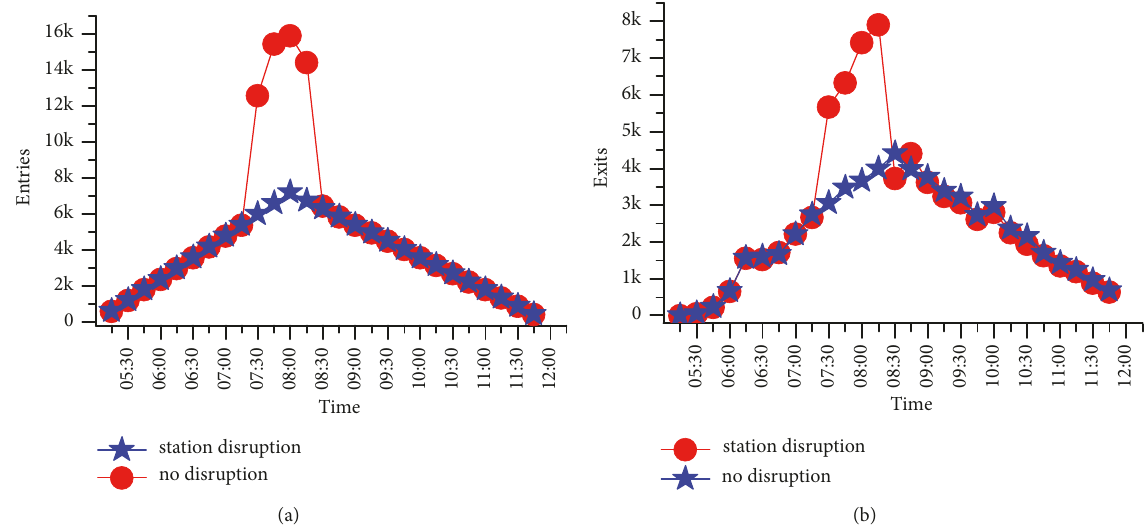
Figure 14: The number of entries and exits at the affected station-Fuxingmen. (a) shows entries of Fuxingmen over time; (b) shows the exits of Fuxingmen over